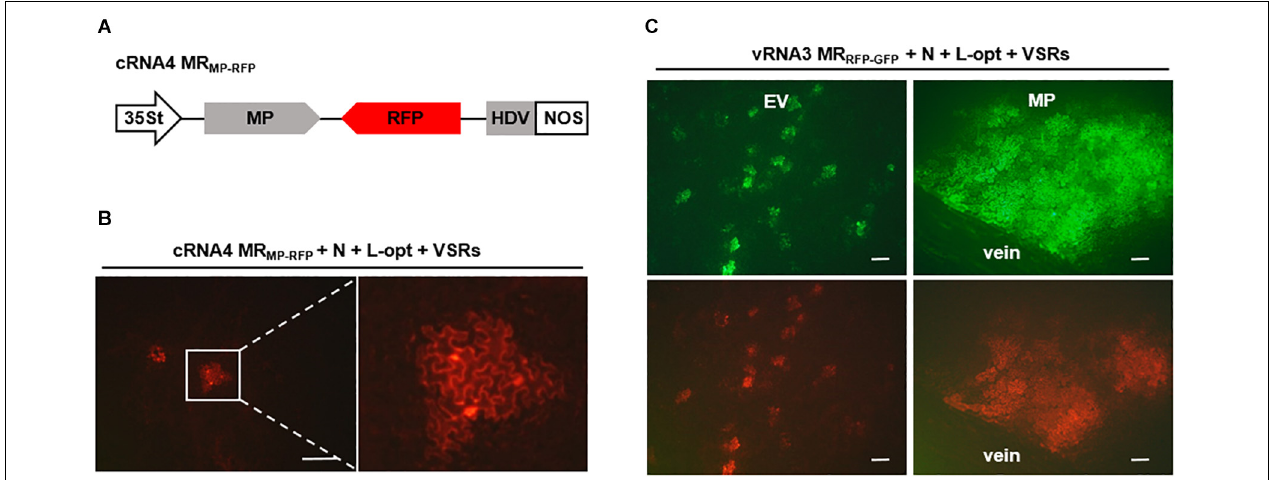
FIGURE 5 | Cell-to-cell movement of in vivo reconstructed MR ribonucleoprotein (RNP) assisted by the rice stripe virus (RSV) movement protein (MP). (A) Schematic representation of RSV cRNA4-based MR MP − GFP . The SP coding region in the complementary-strand of RNA4 was replaced by red fluorescent protein (RFP). (B) Images showing cell clusters with RFP signals in N. benthamiana leaves that were agroinfiltrated to express the N and L proteins, viral suppressors of RNA (VSRs), and cRNA4 MR MP − RFP . The boxed sector is magnified to highlight the movement of RNA4 RNP. (C) Visualization of fluorescent reporter proteins expressed from the reconstructed vRNA3 MR RFP - GFP in the absence or presence of the RSV MP. Leaves of N. benthamiana plants were infiltrated with mixtures of agrobacterial cultures harboring the vRNA3 MR RFP - GFP plasmid, the N- and L-opt expression plasmids, and either an empty binary vector (EV) or an RSV MP expression vector. Infiltrated leaves were photographed at 10 dpi with a fluorescence microscope. Scale bar = 200 µ